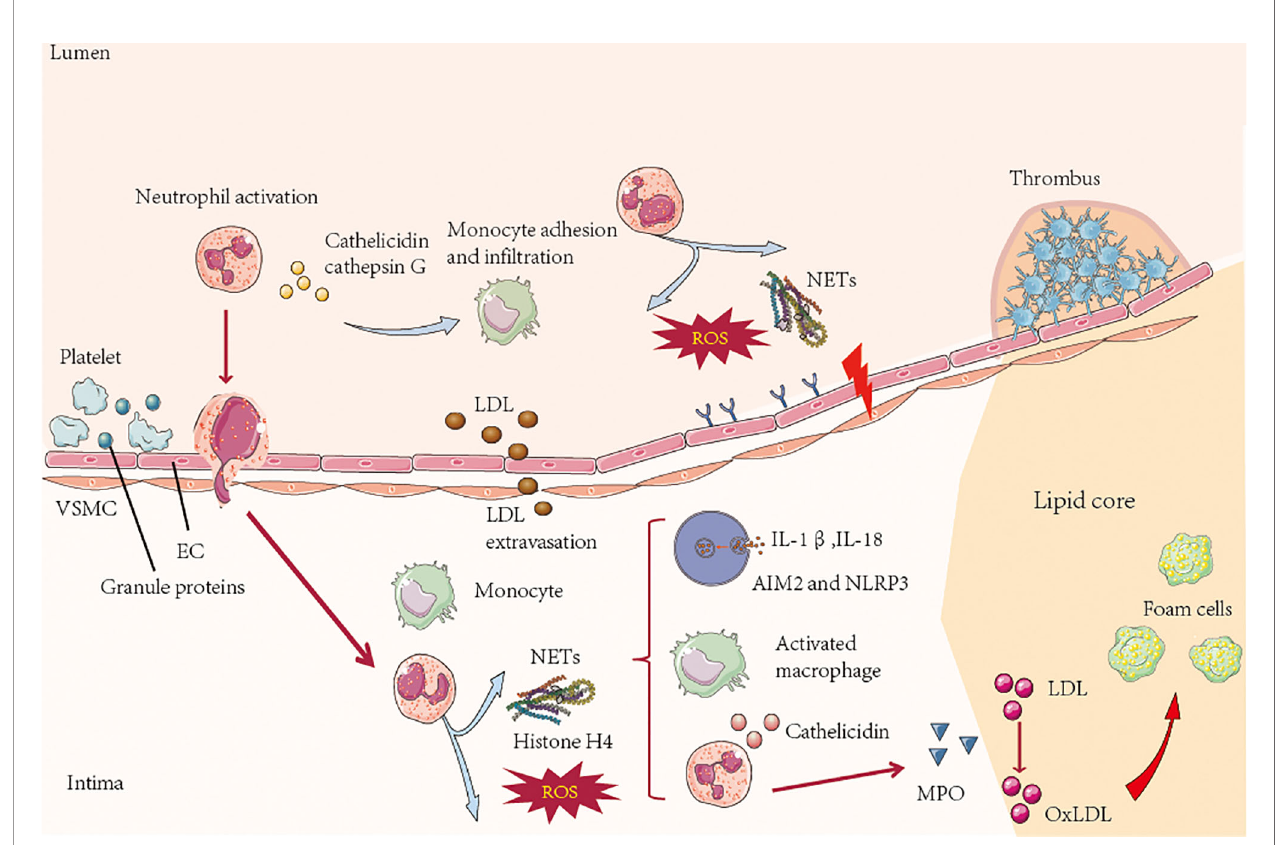
the neutrophil-derived granule proteins antimicrobial peptides and a -defensin activate macrophages and cause them adopt a proin fl ammatory state. Neutrophils secrete MPO, which mediates the oxidation of low-density lipoprotein (oxLDL) and promotes the formation of foam cells. NETs stimulate plasma-like dendritic cells (pDCs) to produce atherogenic interferon (IFN)- a through NLRP3, and macrophages produce IL-1 b and IL-18 but not AIM2 In the late stage of atherosclerosis, neutrophils can destroy plaque stability by secreting a network of proteins including cytotoxic histone H4, which penetrates and eventually dissolves vascular smooth muscle cells (VSMCs). Neutrophil-derived metalloproteinases can also induce VSMC death by degrading ECM. The death of VSMCs and degradation of ECM lead to the thinning of fi ber caps and the formation of vulnerable plaques. Neutrophils can trigger epithelial cell desquamation, which is speci fi cally manifested by